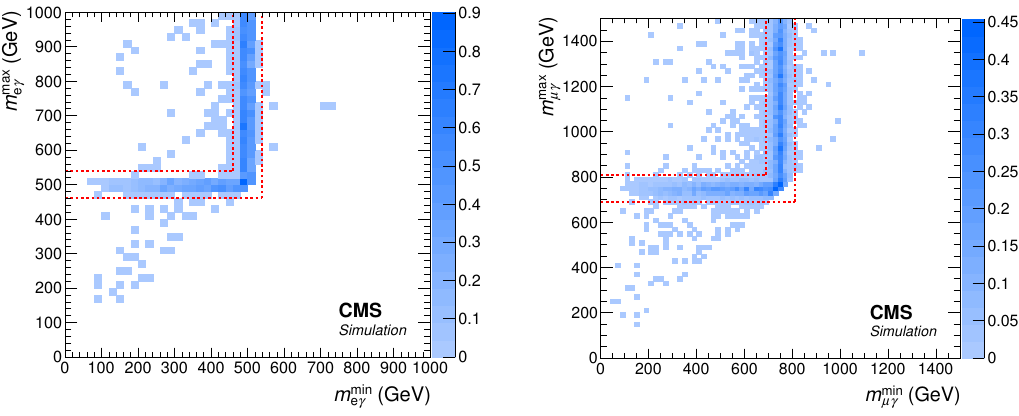
versus m min of excited electrons with a mass ‘(cid:13) ‘(cid:13)